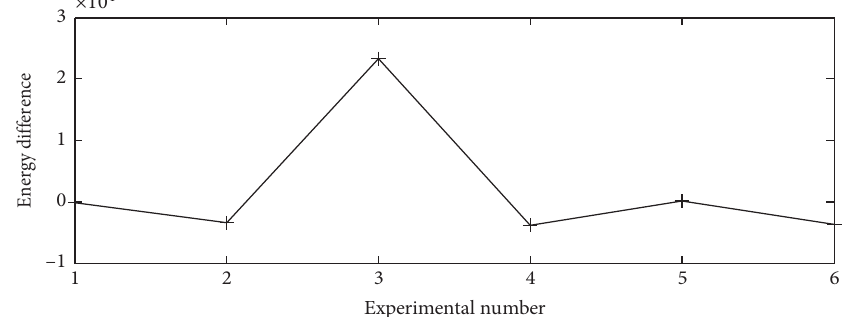
Figure 23: Signal energy difference between constant and TVPA conditions of s- p